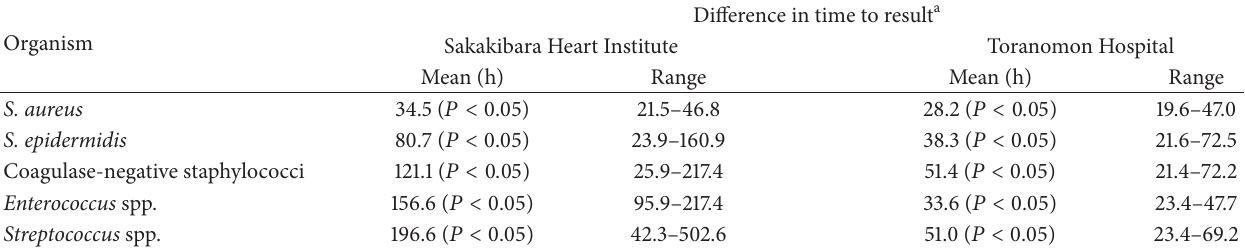
Table 3: Difference in time to final identification and antimicrobial susceptibility report.